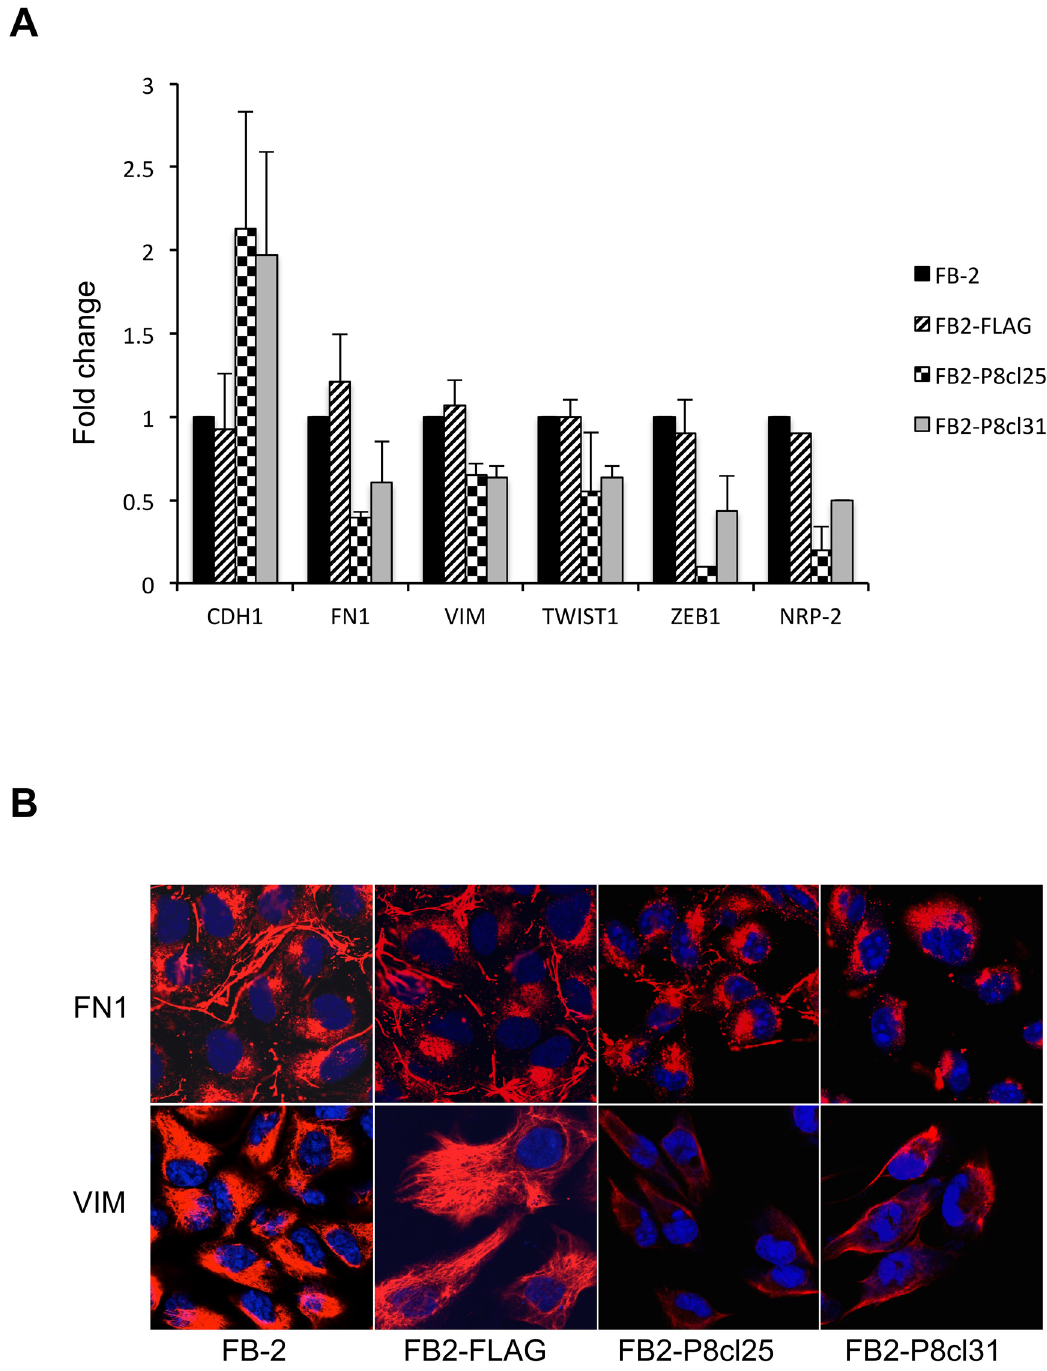
Fig 4. Effect of NRP2 downregulation on EMT in thyroid cancer cells. (A) qRT-PCR analysis was performed on total RNA prepared from wild-type FB-2 cells and individual Pax8 stable clones. The expression of E-cadherin, fibronectin-1, vimentin, twist-1 and zeb-1 was measured. The values are means ± SD of three independent experiments in duplicate, normalized by the expression of ABL1 and expressed as fold change with respect to the expression in FB-2 control cells, whose value was set at 1.0. Statistical analysis uses t-test (p (cid:3) 0.05). (B) Indirect immunofluorenscence showing vimentin and fibronectin-1 staining in control cells and Pax8 stable